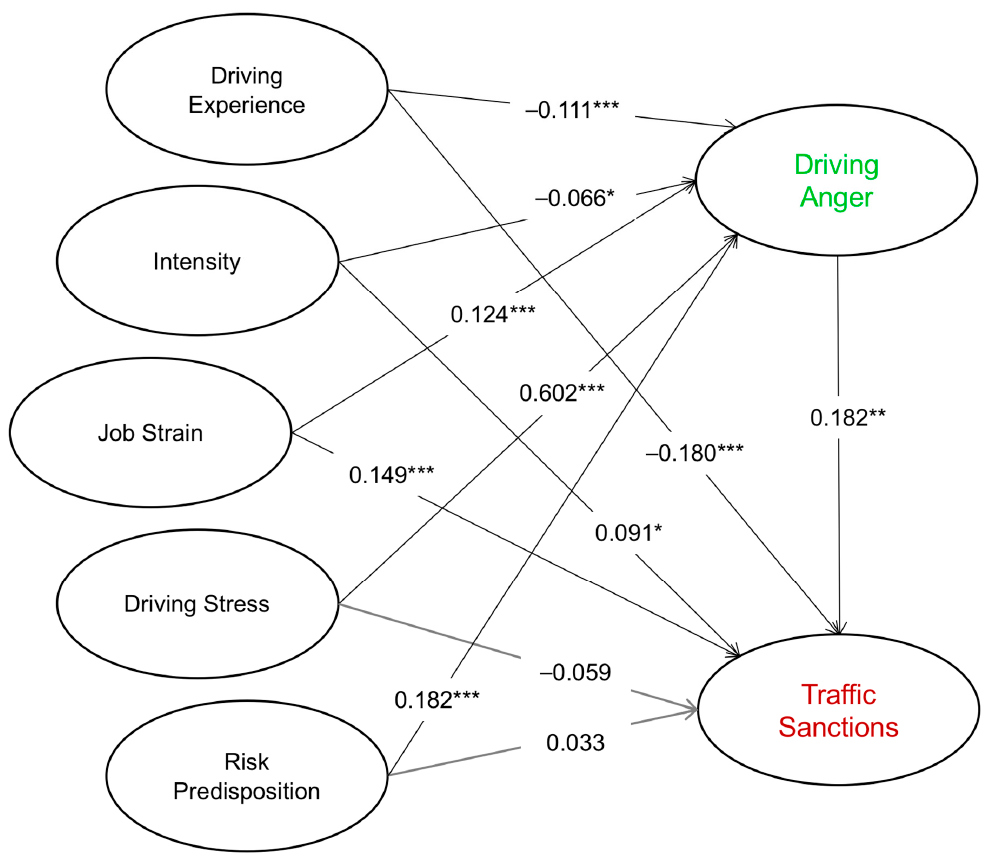
Figure 1. Graphic presentation of the Structural Equation Model (SEM). *** Significant at level 0.001; ** Significant at level 0.01; * Significant at level